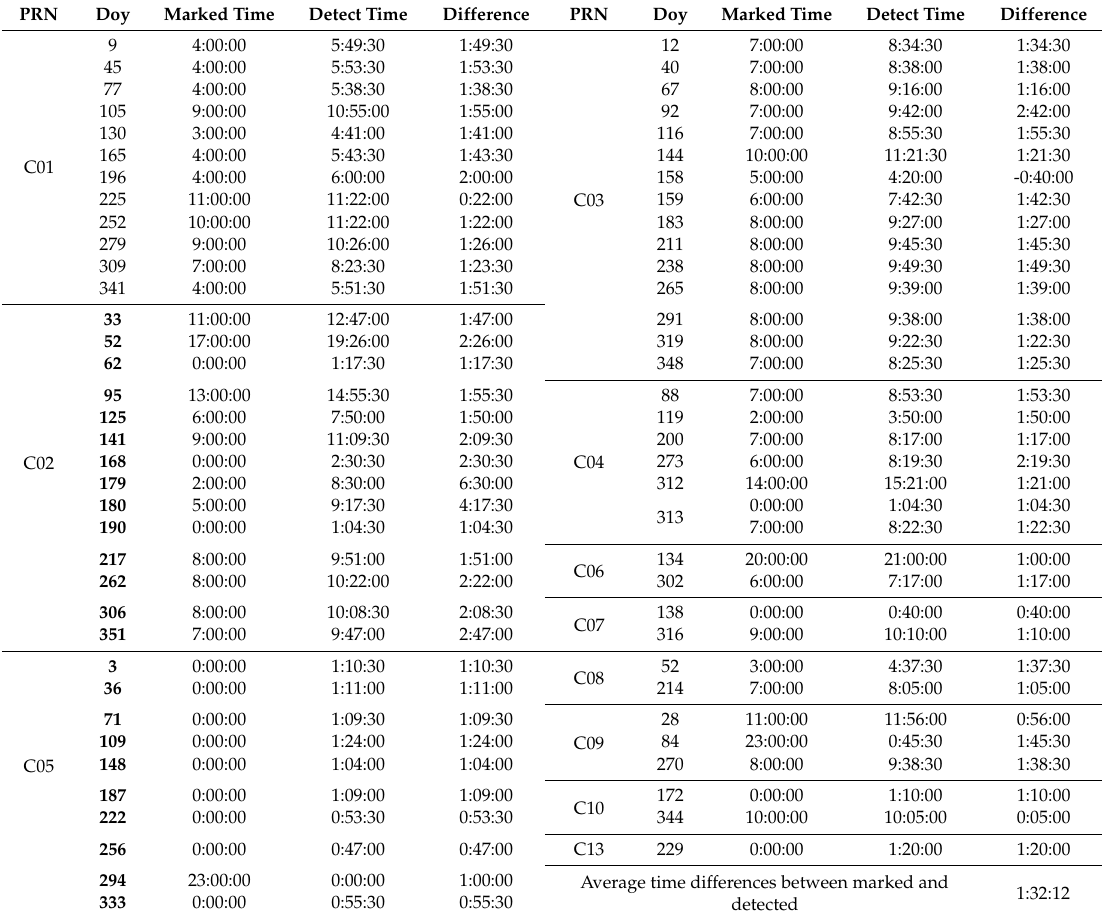
Table 2. Results of orbital maneuver detection in 2016 for BeiDou GEO/IGSO satellites.